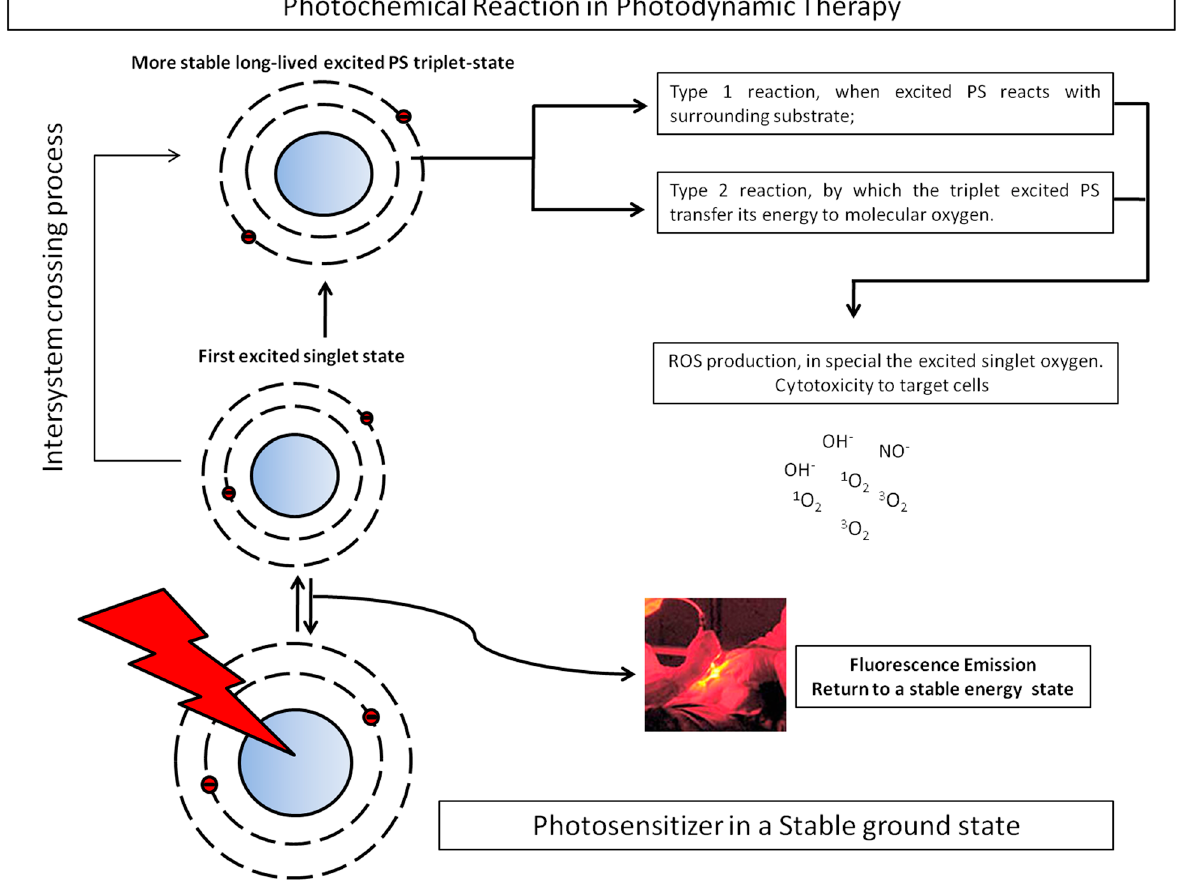
Figure 1. When excited by light at a specific wavelength, the photosensitizer (PS) reaches its first excited singlet state. This state can decay by emitting fluorescence or, alternatively, it reaches the more stable excited triplet state through the intersystem crossing process. The PS in its triplet state can directly react with biomolecules (Type 1 reaction) or with the triplet oxygen producing the singlet oxygen (Type 2 reaction), which is much more oxidative than the triplet oxygen. Although both of these reactions can damage cells, the most significant damage is induced by Type 2 reactions. On the right side is a photograph showing a patient being laser-irradiated: fluorescence emission can be used for detecting the